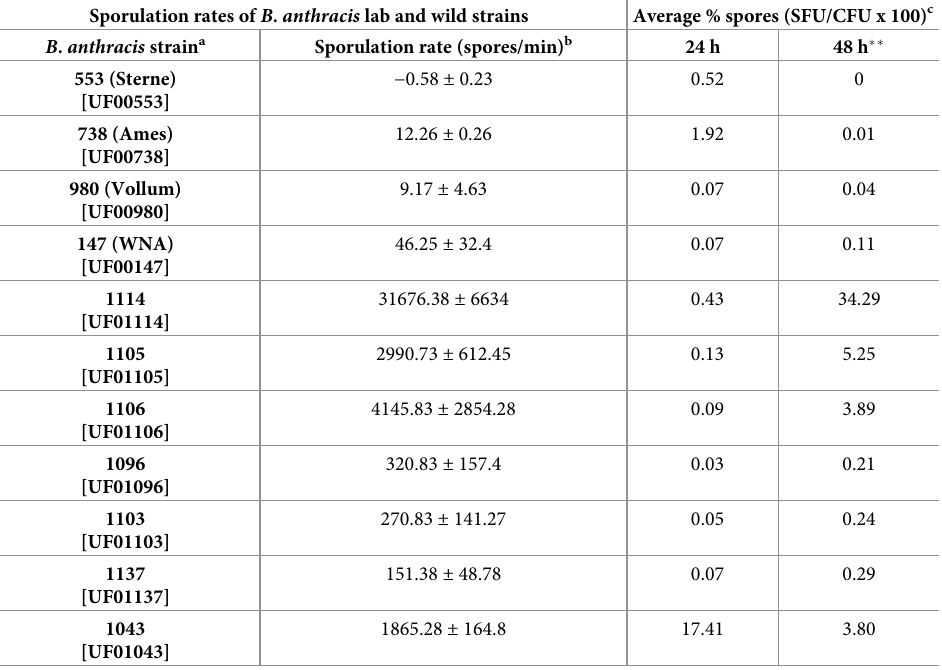
Table 2. Sporulation rates and average spores after growth at 30˚C in